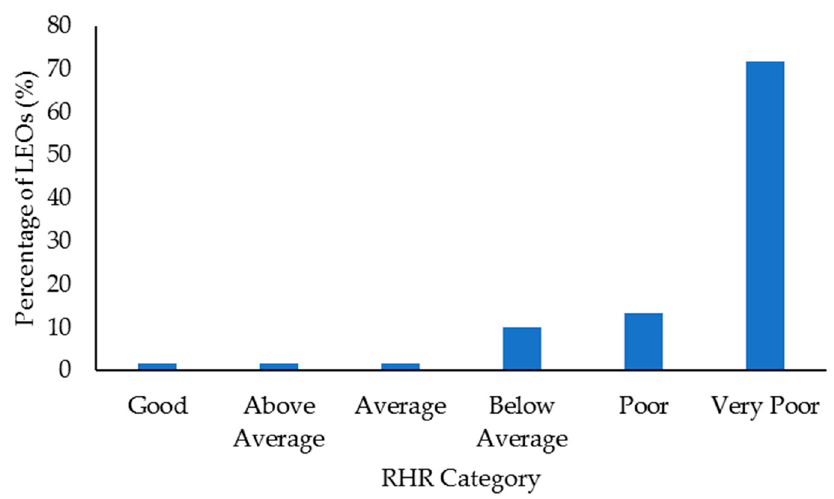
Figure 4. Percentage of law enforcement officers (LEOs) in this sample ( n = 60) classified according to the resting heart rate (RHR) categories.